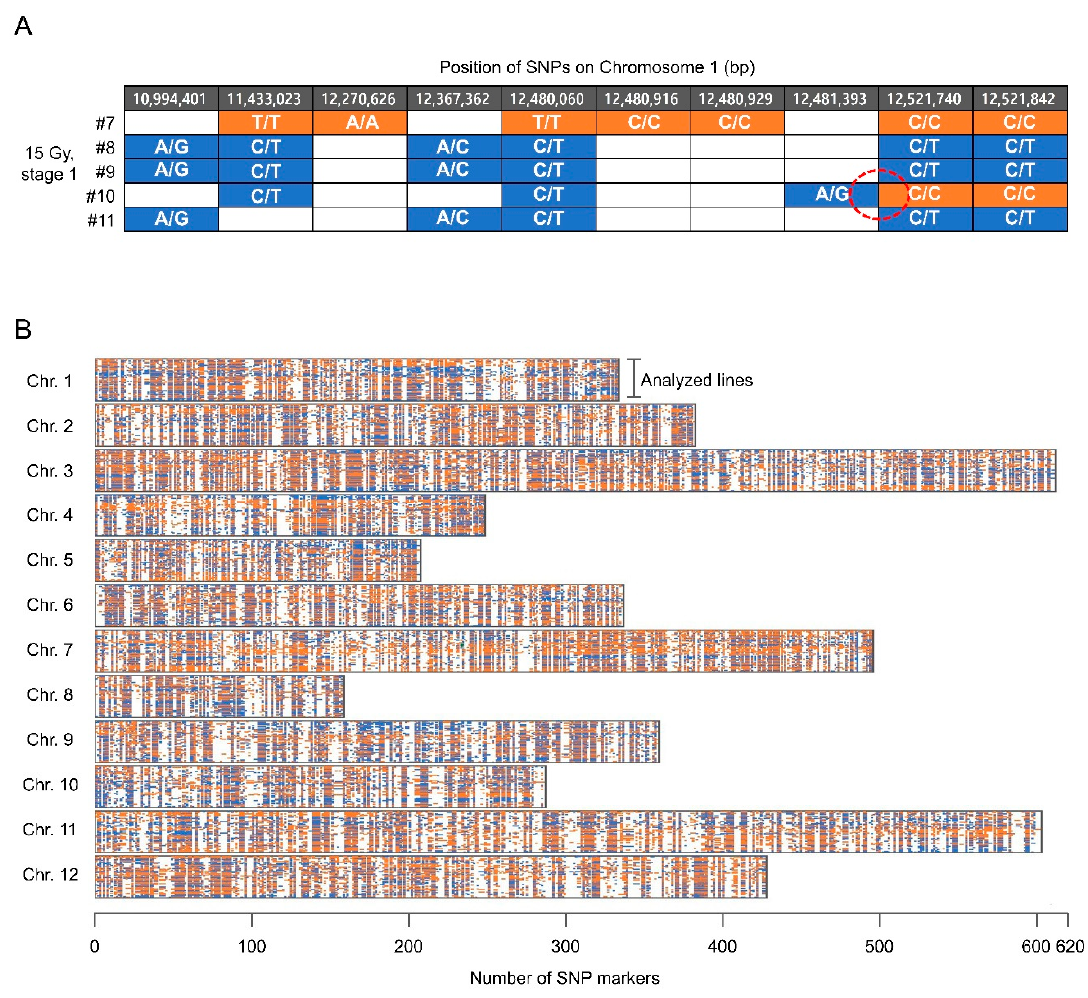
Figure 4. Estimation of recombination using single nucleotide polymorphism (SNP) markers distributed along pepper chromosomes. ( A ) Example of recombination detected based on changes in the zygosity levels between adjacent SNP markers; ( B ) Distributions of SNP markers along the 12 pepper chromosomes. Table 2. Characteristics of single nucleotide polymorphism (SNP) markers used for the estimation of recombination frequencies.